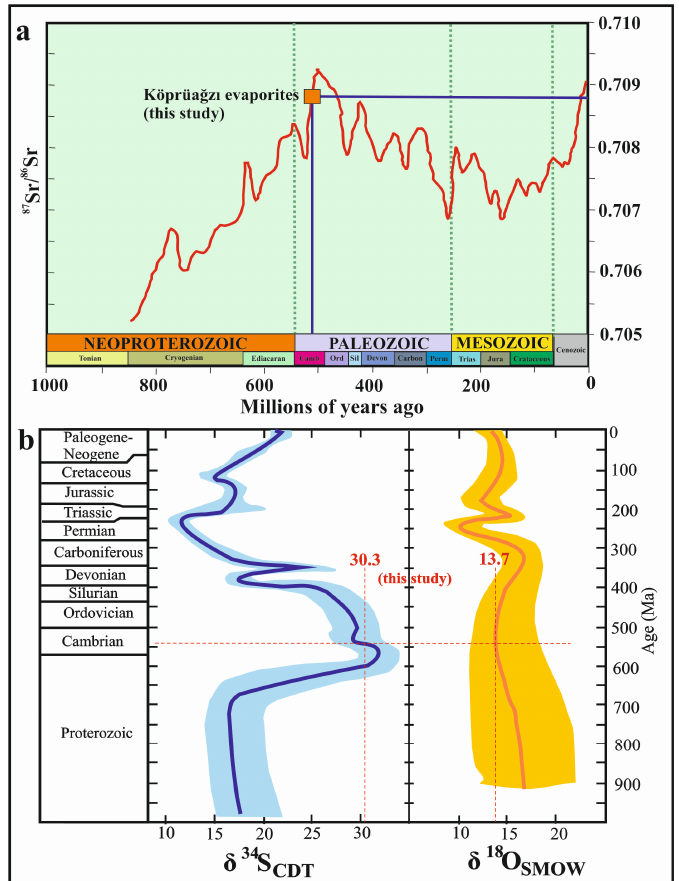
Figure 8. ( a ) 87/86 Sr isotopic curve of seawater strontium during the latest 1000 Ma interval (modi fi ed from [77,78,80]); ( b ) marine sulfate sulfur and oxygen isotope age curves (modi fi ed from [85]). The bold line is their best estimate of global oceanic sulfur and oxygen isotope compositions and the shaded area shows an estimate of uncertainty for the curve. The point where the red dashed lines intersect belongs to the study area samples.